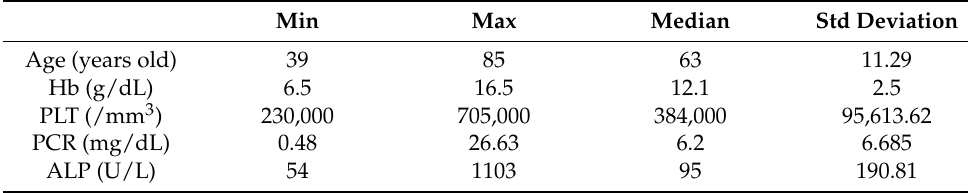
Table 1. Data analysis of patients with CRC and PC.